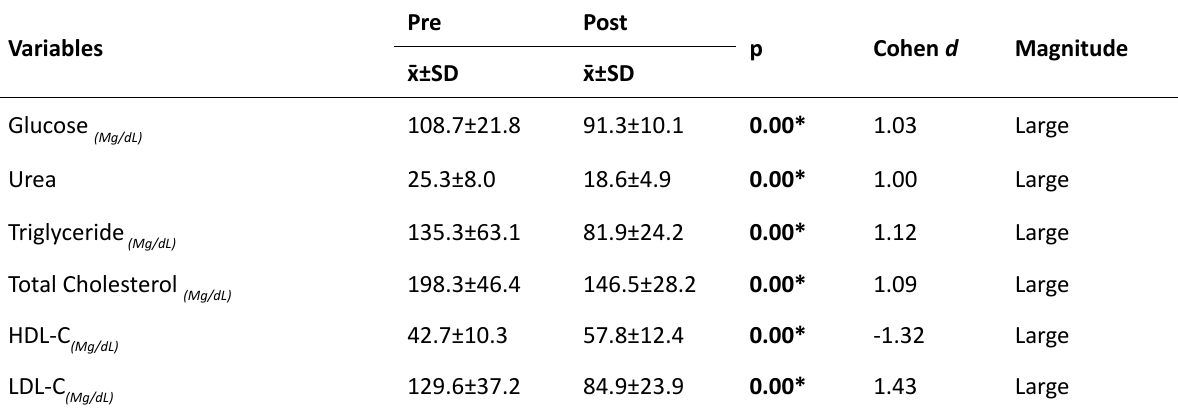
Table 3. Changes in blood lipid before and after 8-weeks Zumba exercise program